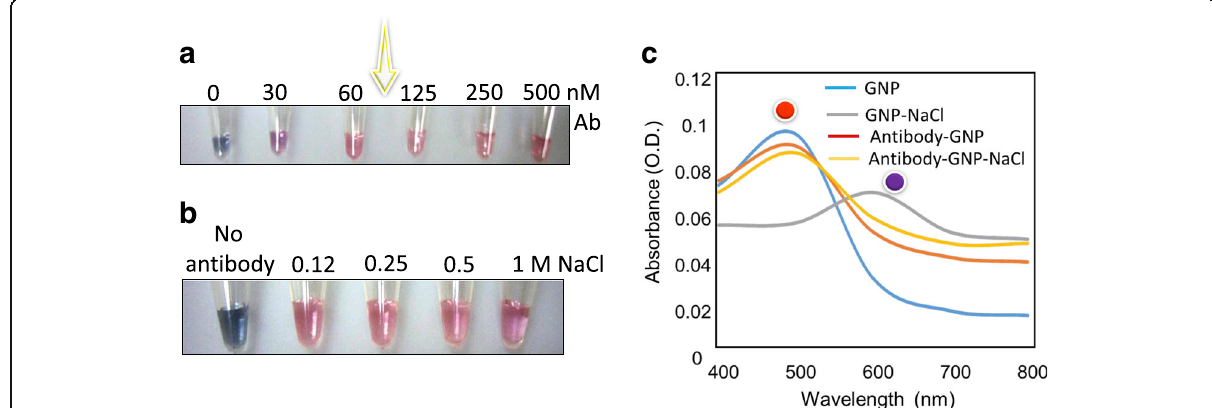
Fig. 3 ESAT-6 antibody optimization and stability. Different concentrations of anti-ESAT-6 antibody were tested using 800 mM NaCl. a Aggregation or dispersion of GNP with the anti-ESAT-6 antibody (0 to 500 nM); Arrow indicates the transition region for the optimal antibody concentration. b Stability of 60 nM of antibody complexed GNP with different NaCl concentrations (0.012 to 1000 mM). c Spectra for different complexes. Peaks were indicated with the respective colored